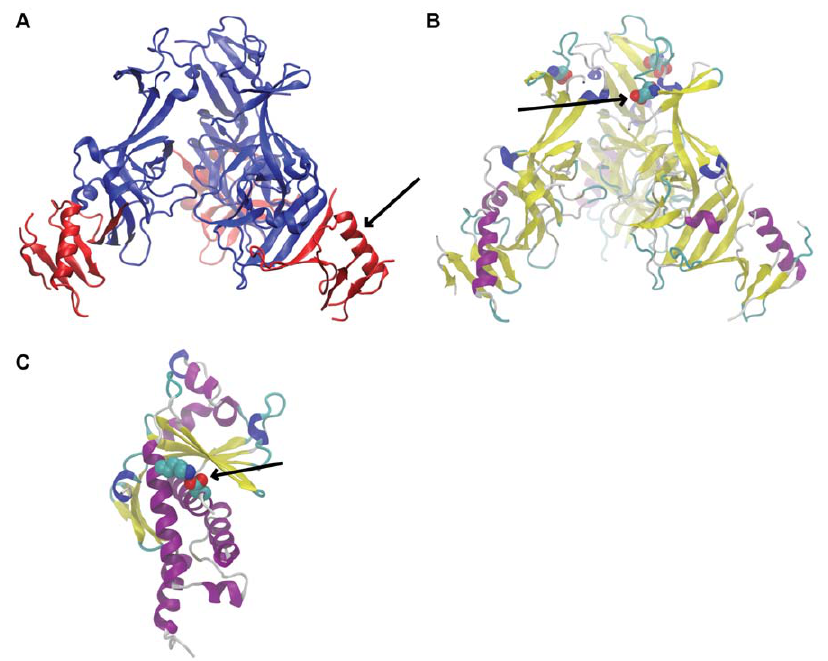
Figure 3. Predicted protein conformational changes. Locations of the observed mutations within the structures of EBOV proteins: a) GP truncations – occur right after a disordered region in the crystal structure. The truncation also removes the ends of the trimer (in red). b) GP 1,2 – residue E47 (vdW spheres) is near the top of the trimer and, in the X-ray crystal structure (3CSY), makes no interactions with other side chains. c) VP24 – residue K163 forms a tight salt-bridge with D104 on another helix near an undetermined loop in the X-ray